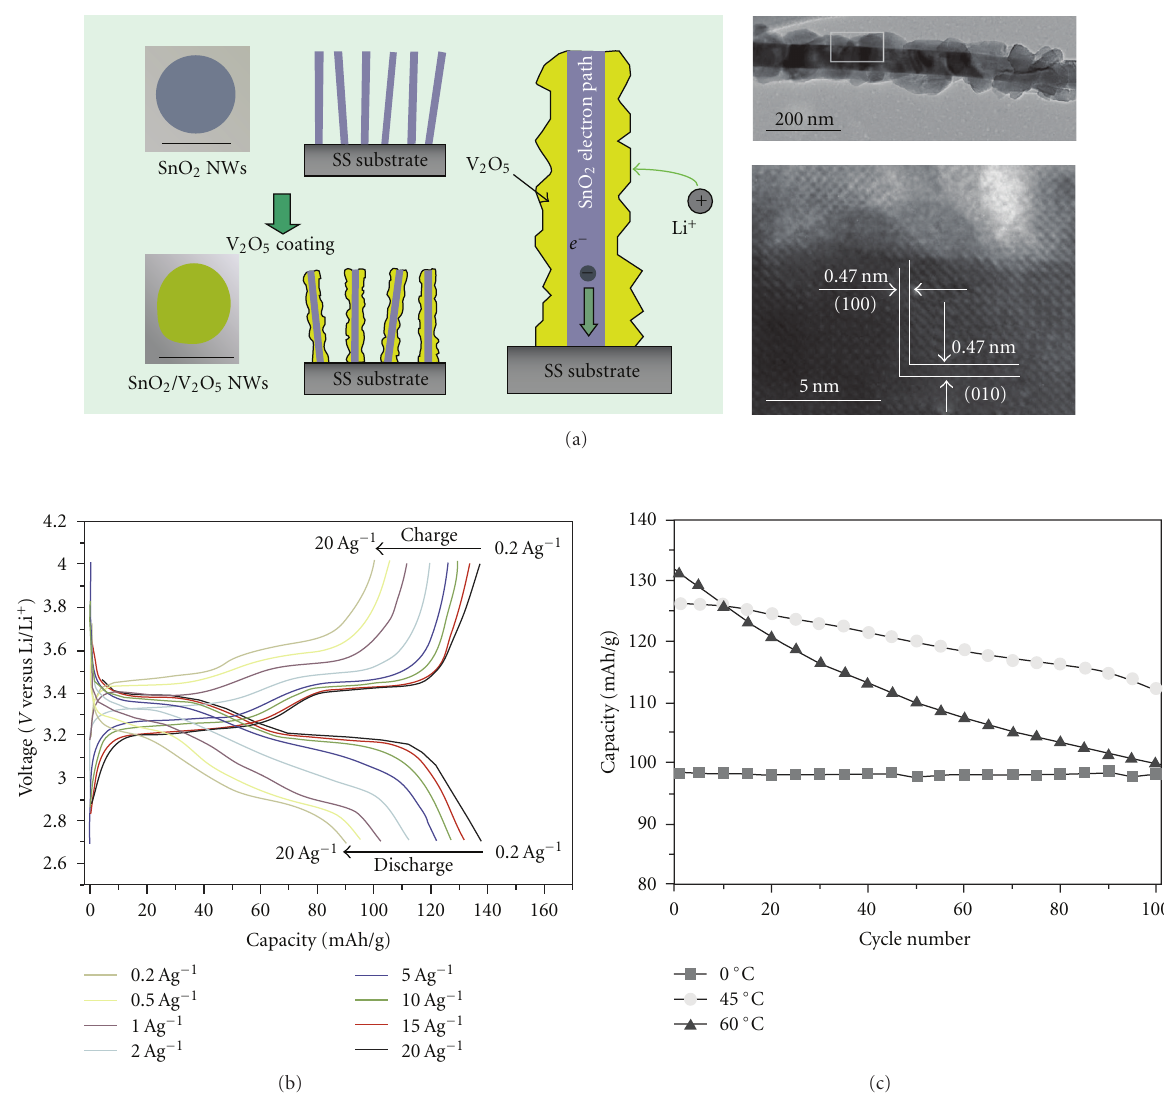
Figure 9: (a) Schematic diagram showing the strategy for coating V 2 O 5 on SnO 2 nanowires, and typical TEM images of a single SnO 2 /V 2 O 5 core/shell nanowires, (b) the galvanostatic charge/discharge curves at di ff erent current densities, and (c) the cycling performance at di ff erent temperatures of the SnO 2 /V 2 O 5 core/shell nanowires electrode